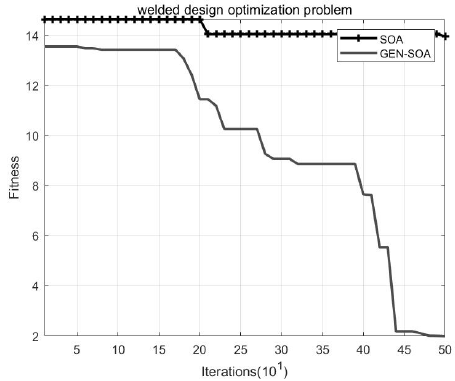
Figure 4. The welded design.